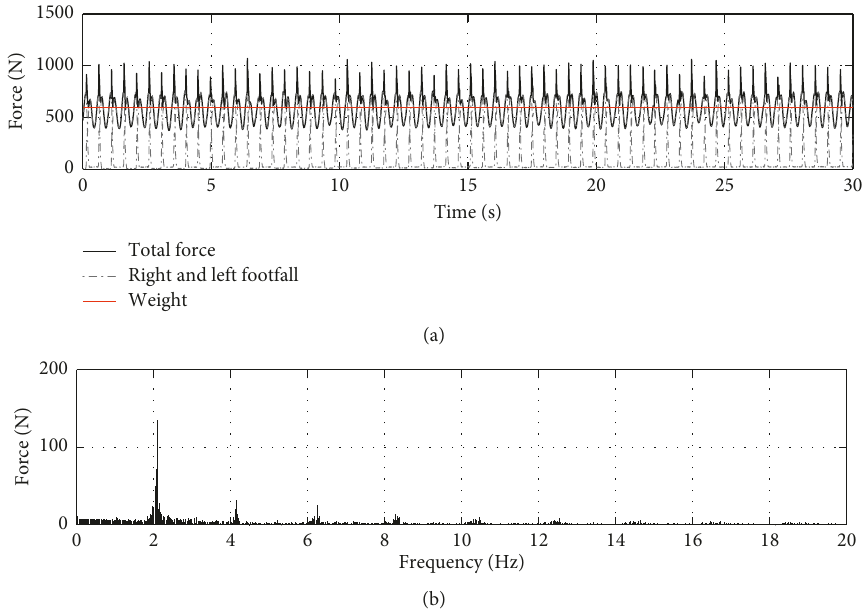
Figure 1: Walking force time history and Fourier spectrum at a speed of 1.341 m/s.